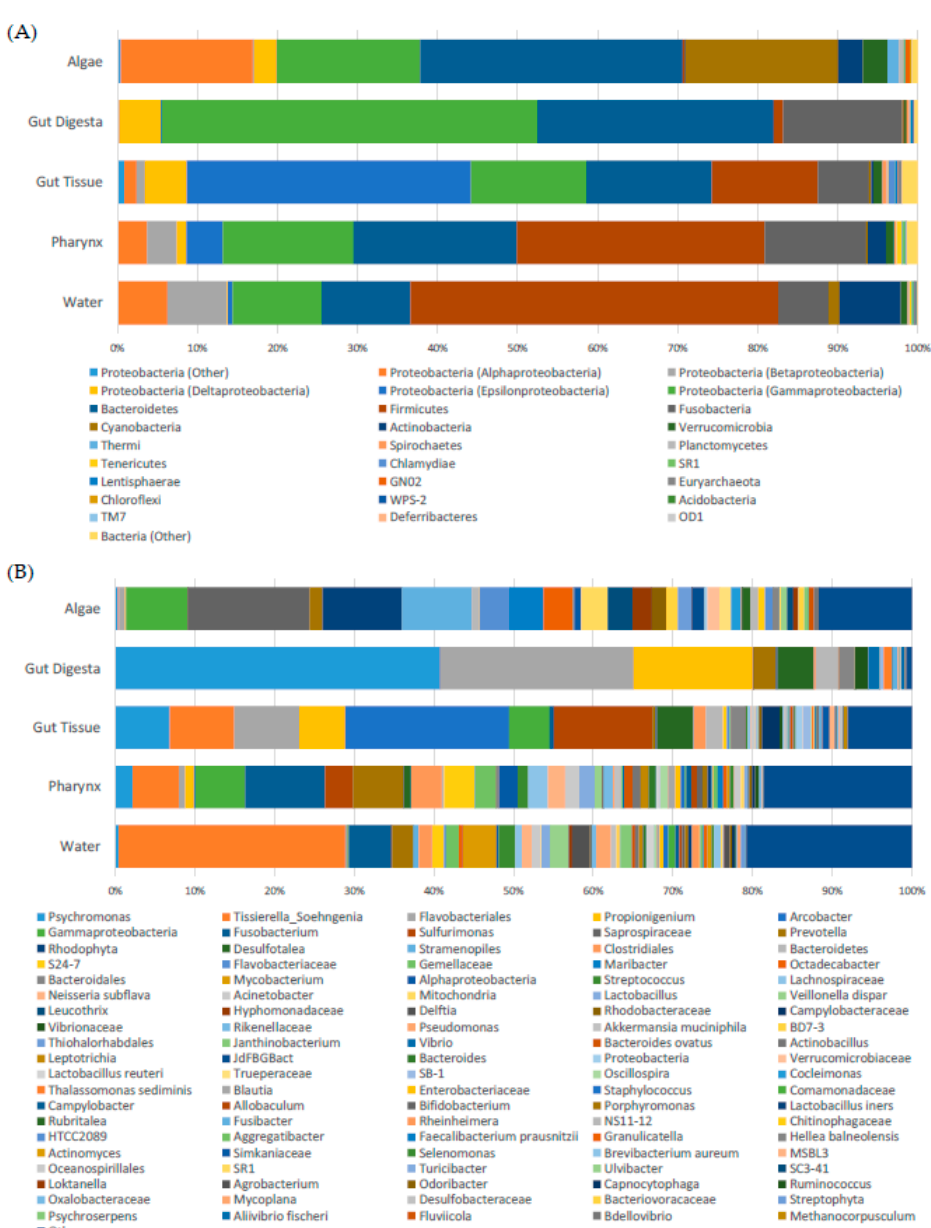
Figure 2. Taxonomic distribution of microbial communities in the gut ecosystem and rocky tide pool environment of the sea urchin S. purpuratus . ( A ) The relative abundance of phyla (class for Proteobacteria) represented at >1% are shown, with phyla <1% grouped as “Other.” ( B ) The top 100 taxa at the most resolvable level across all samples were also visualized, and taxa not included as the top 100 were assigned as “Other.” OTUs were picked at 97% similarity threshold, filtered at <0.0005%, condensed using PhyloToAST (v1.4.0), and subsampled to minimum OTU count (rarefied OTU table). Taxonomic identities were determined by using the GreenGenes (v13.8) database, and the color code corresponds to each taxon observed across the gut and environmental samples. Grouping of biological replicates ( n = 3) was supported by an analysis of similarity (ANOSIM) and multivariate analysis of variance (Adonis) ( p < 0.001). Relative abundance plot was created through Microsoft Excel Software (Seattle, WA, USA).